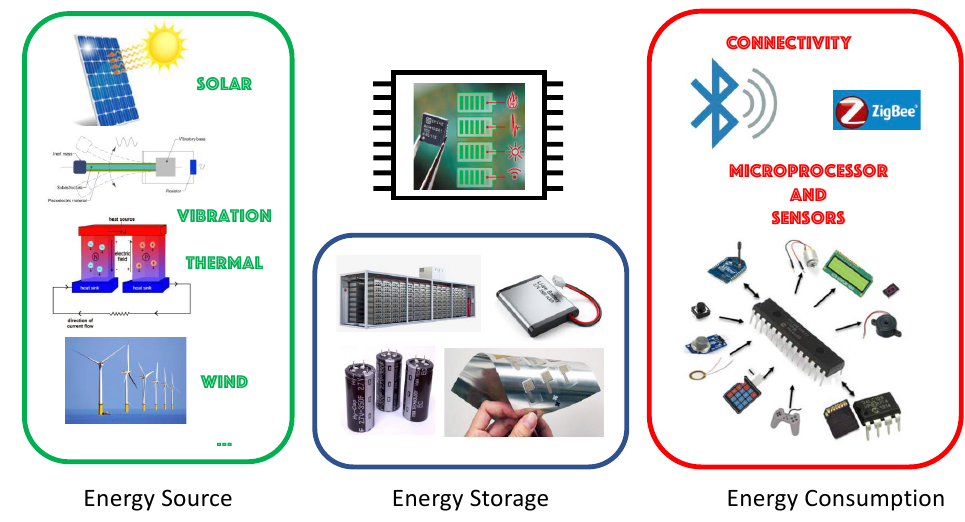
Figure 1. IoT is connecting the world.